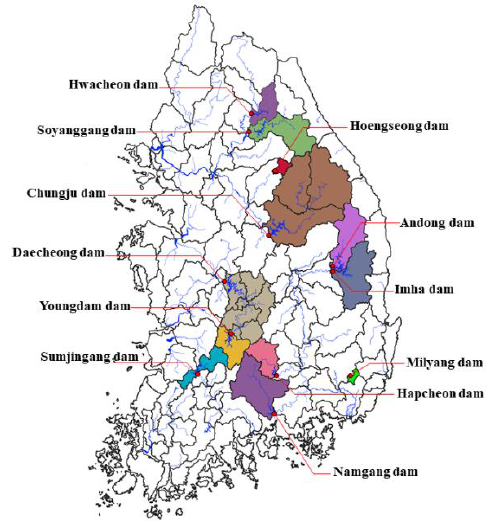
Figure 3. Description of study area; red circles indicate the location of each dam and colored areas indicate the upstream area of each